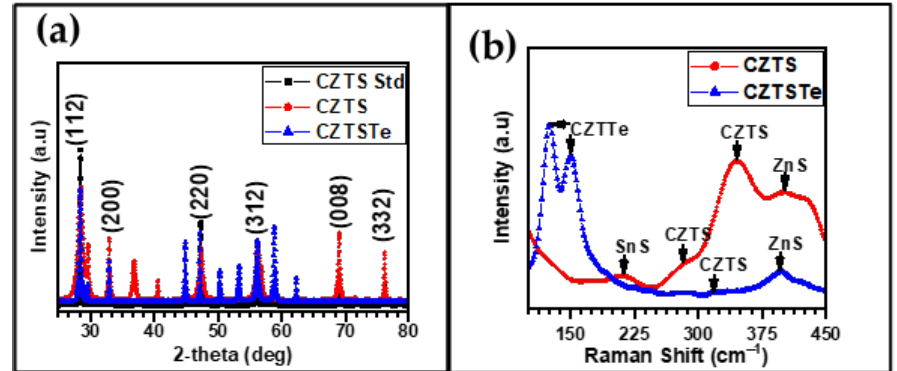
Figure 3. ( a ) XRD and ( b ) Raman spectra of CZTS and CZTSTe nanomaterials.